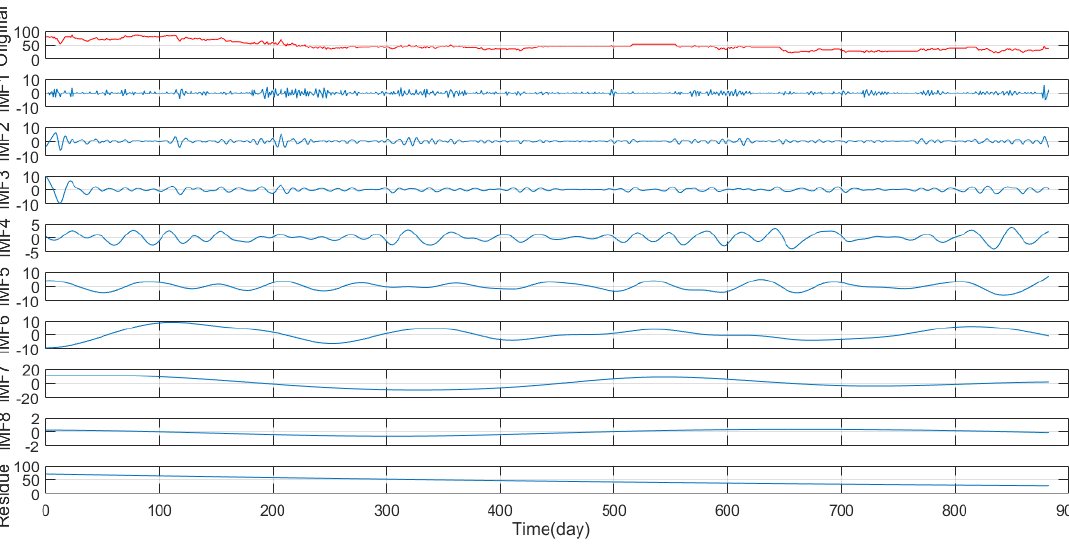
Figure 3. The decomposition of the SZA2013 sequence using the EEMD.